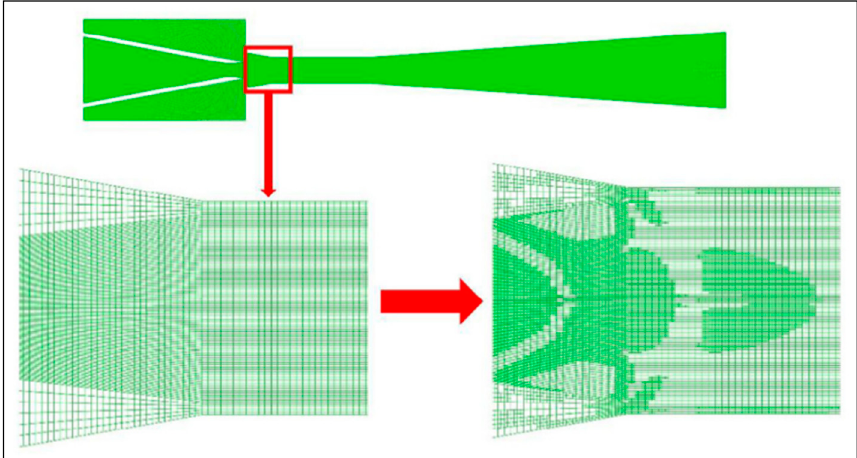
Figure 22. Grid adaptation around shocks [224].